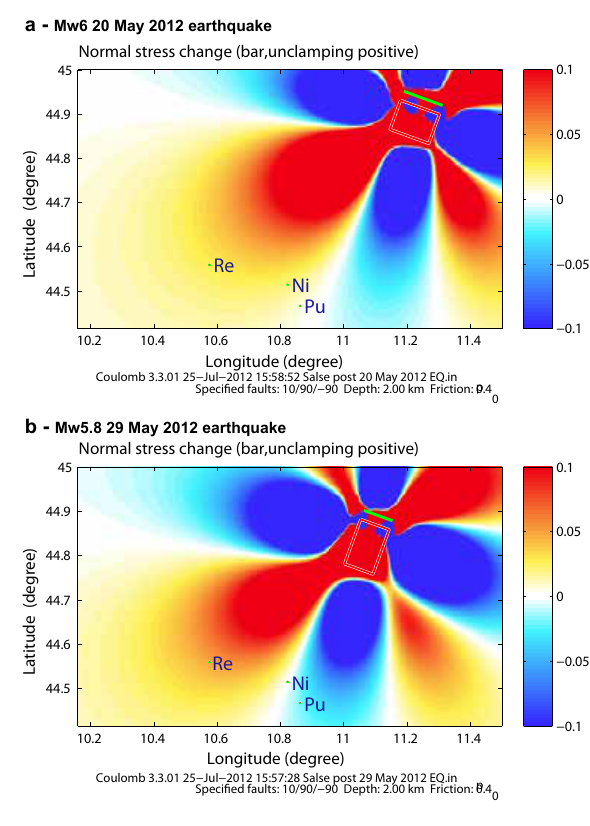
Fig. 5. Field observations of mud volcano response to the May 2012 Emilia earthquakes. (a) New mud cone at Casola-Querzola, look- ing northwest (24 May 2012). This ∼ 50-cm-tall cone and other smaller vents developed after the 20 May 2012 earthquake on top of a decametre-sized mud mound that had remained inactive dur- ing at least the last 7yr; hammer for scale. (b) Same cone (look- ing southeast) as that in (a) , where significant activity continued after the 29 May 2012 earthquake; on 31 May 2012 (the date of this photo), activity was characterized by intermittent bursts that ejected mud and gases. (c) Large mud flow at Regnano. The main cone started to extrude mud after the M w = 5 . 9 − 6 . 0 20 May 2012 earth- quake, and continued extruding for several days after the M w = 5 . 8 29 May 2012 earthquake. The final outcome is an approximately 60-m-long mud flow, which was completely dry on 10 August 2012 (the date of this photo); persons (circled) for scale.